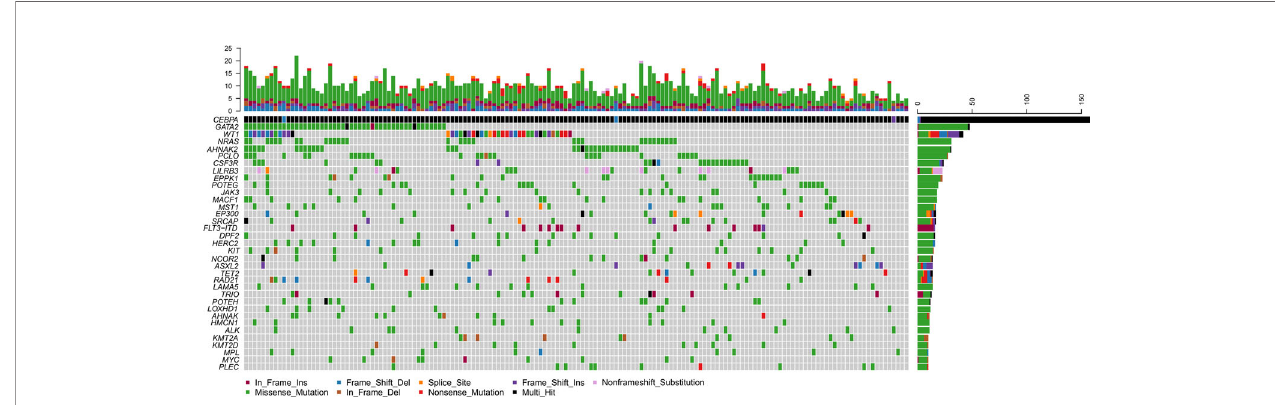
FIGURE 2 | Genomic landscape of 158 CN-AML patients with bi CEBPA mutations. Genes mutated in ≥ 10 patients are shown. Boxes are colored according to the mutation type. Black box indicates multi-hit of mutation type. Non-black box of CEBPA indicates the same mutation type in one patient. The top bar indicates mutation load (mutation/Mb DNA) and the right bar indicates mutation frequency.